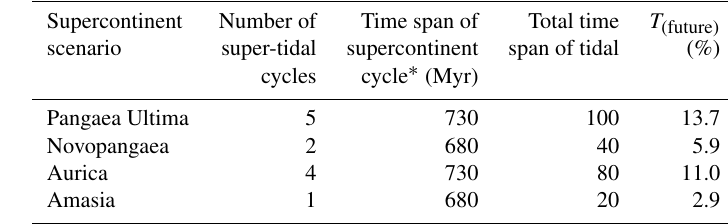
Table 1. Summary of the number of super-tidal peaks for each scenario. Supercontinent Mode of Number of Resonant basin(s), Average scenario supercontinent super-tidal peaks, including PD normalized ∗ formation incl. PD dissipation Pangaea Ultima Introversion 5 Atlantic, Pacific, Pacific and Atlantic, 0.877 Pacific and Atlantic, Pacific Novopangaea Extroversion Atlantic, Pacific Aurica Combination